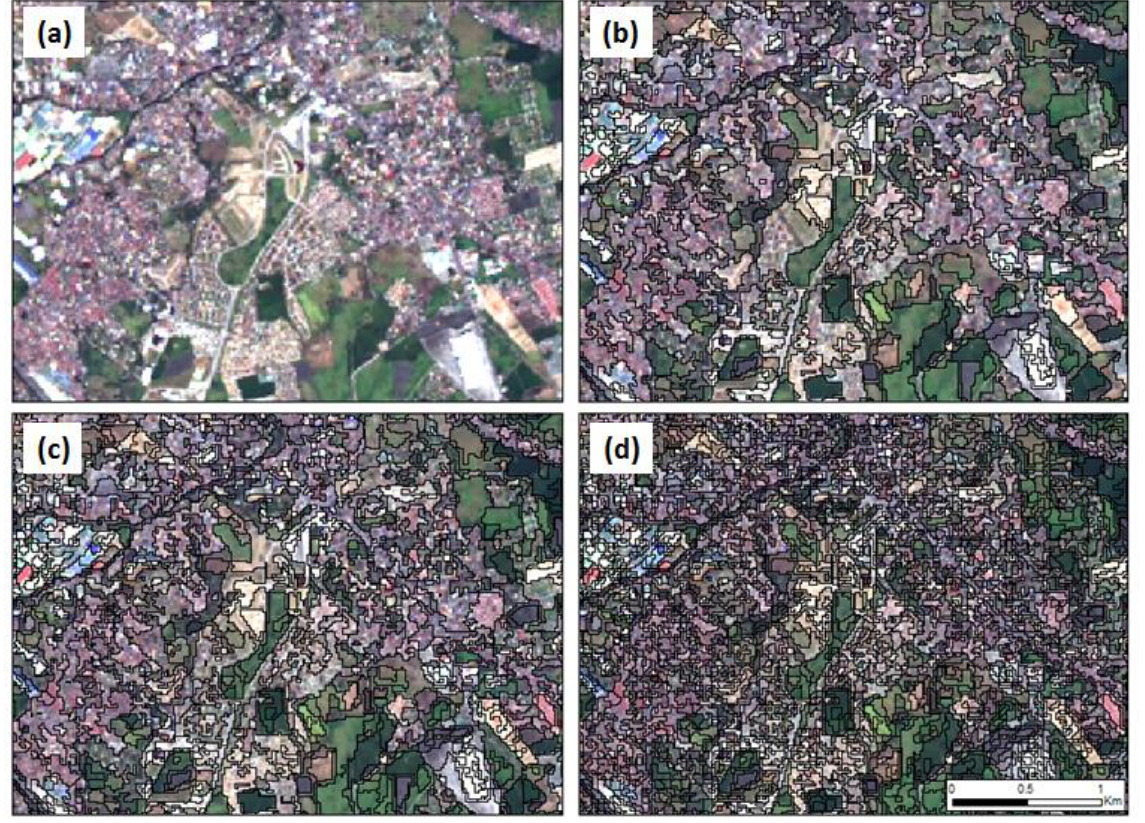
Figure 3. ( a ) Subset of the study area image. Optimal segmentations for the three-level GEOBIA approach: ( b ) SP120 segmentation; ( c ) SP80 segmentation; ( d ) SP40